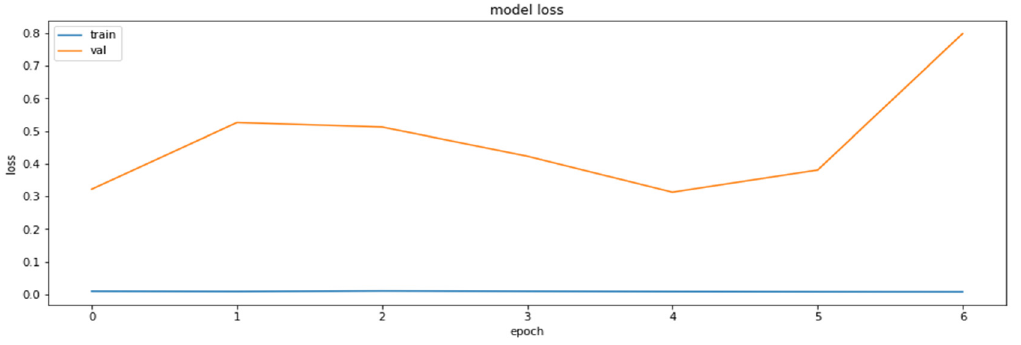
Figure 11. The loss function values for the training and the validation datasets based on QAT part of the PCQAT method.